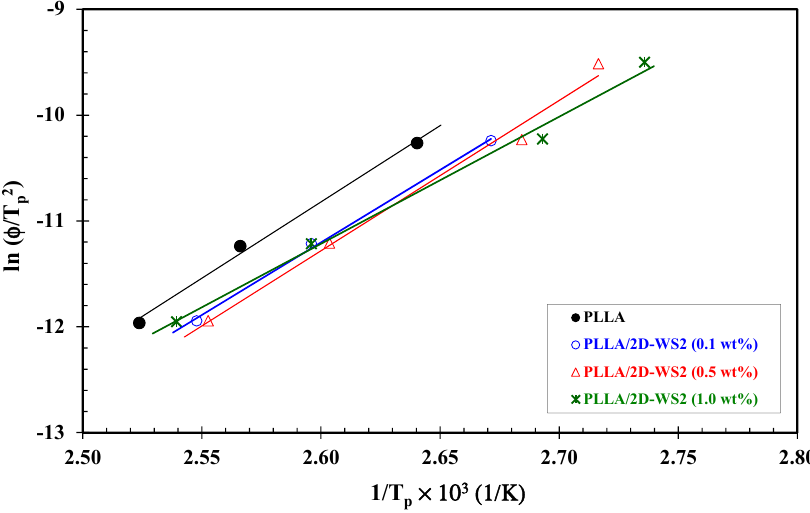
ff ective energy barrier of PLLA / 2D-WS